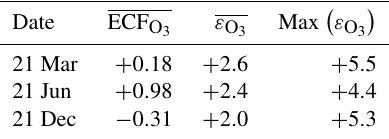
Table 6. Discrepancies between the instant-dilution approach and APCEMM at cruise altitudes. The left-most column shows the av- erage ozone ECF as calculated in APCEMM, while the central col- umn shows the average discrepancy in ECF between the instant- dilution model and APCEMM. The right-most column shows the maximum calculated error. A positive error value means that the instant-dilution model overestimates ozone production. All vari- ables are evaluated and averaged over cruise altitudes